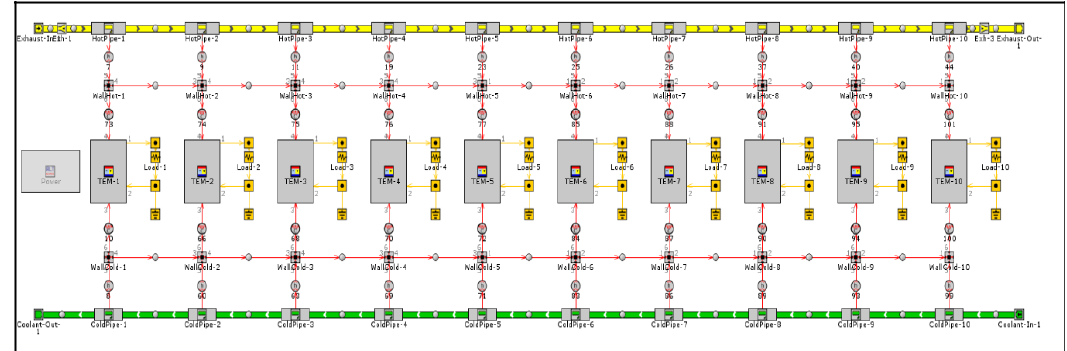
Figure 6. TEG Model with 10 TEG modules.